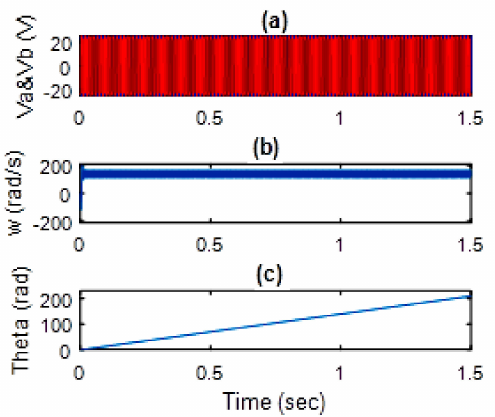
Figure 10. Results of proposed model at T L = 0.2 Nm and period of time 0.015 s: ( a ) phase voltages, ( b ) speed, and ( c ) displacement